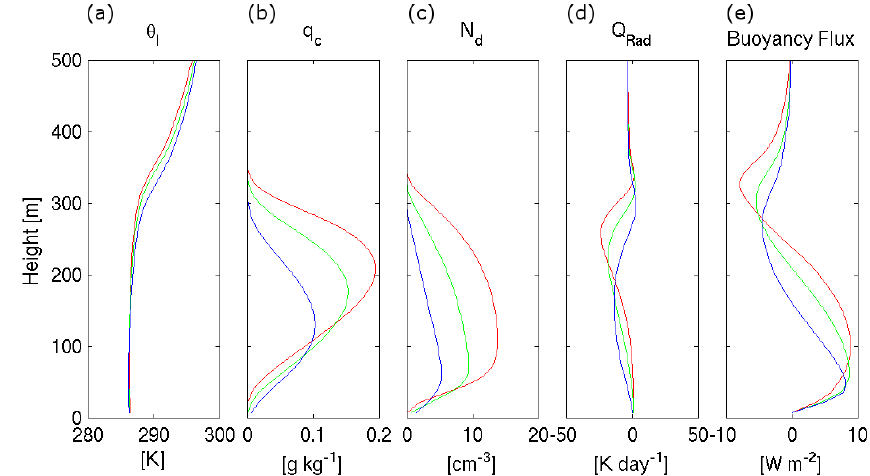
Figure 9. Domain average profiles from run BaseCtrl for (a) liquid-water potential temperature θ l , (b) cloud water q c , (c) cloud droplet number concentration N d , (d) radiative heating rate Q RAD , and (e) resolved buoyancy flux B . Times shown are for hours 8 (red), 12 (green), and 16